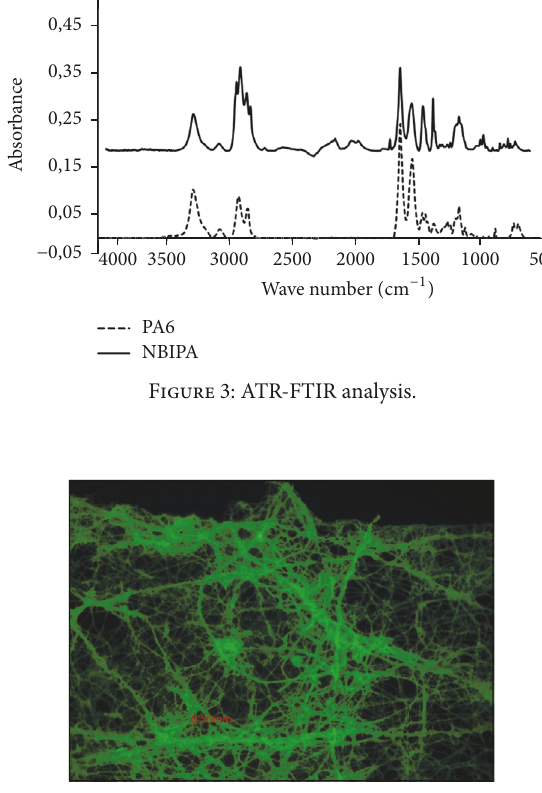
Figure 4: Fluorescence microscope image of NBIPA.